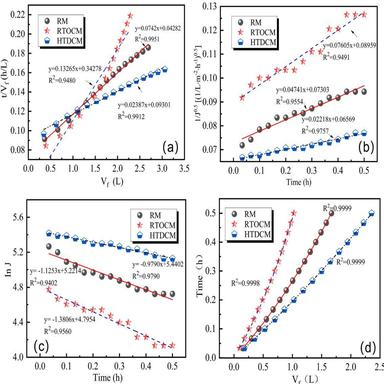
Experimental data of RM, RTOCM and HTDCM in the second cycle of filtration predicted by the (a) CF, (b) PN, (c), PB, and (d) MF models.